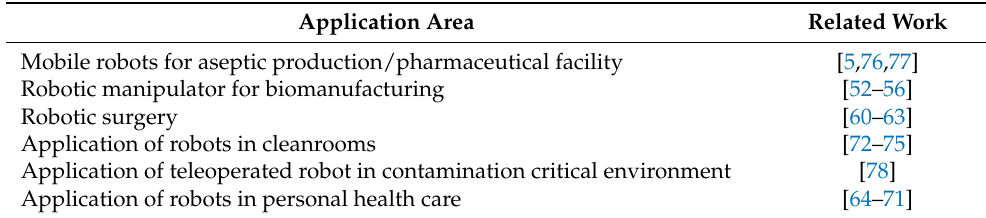
Table 4. List of relevant work discussing the application of fixed and mobile robots in areas very close to the field of biomanufacturing and personal